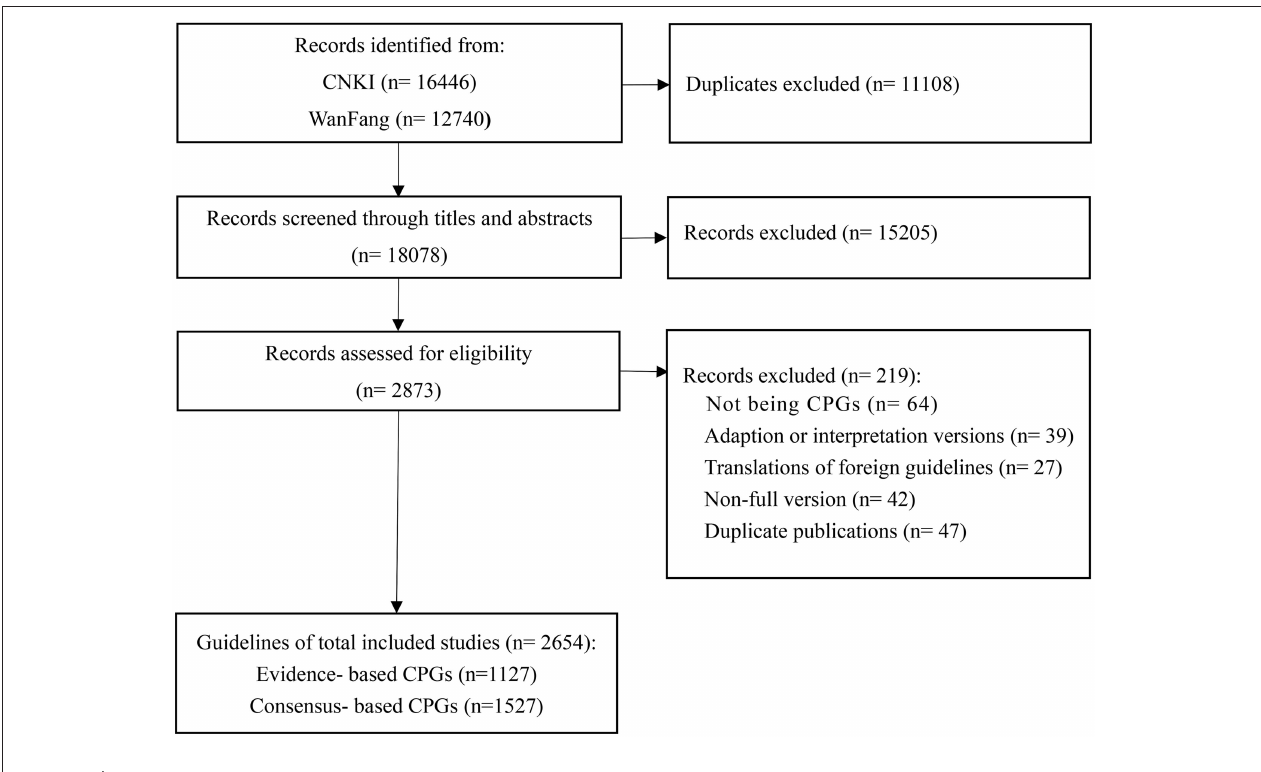
FIGURE 1 | The flowchart for guideline selection.